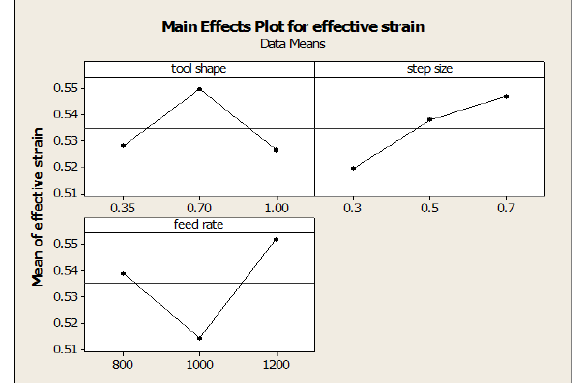
Fig. 14. Main effect plot (Data means) for average effective strains on the 55 ◦ forming angle.